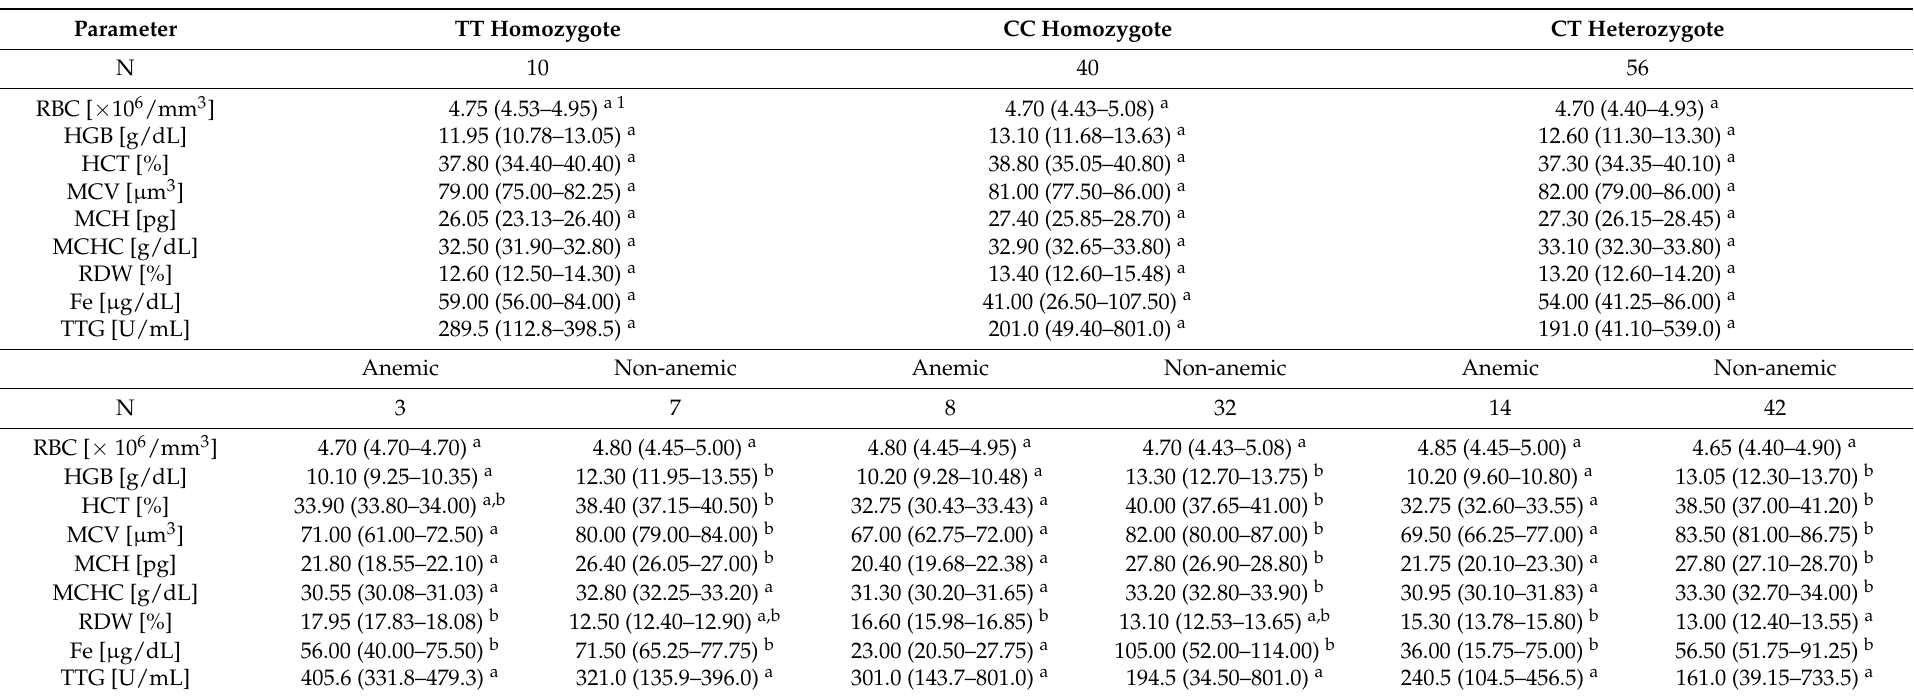
1 Comparison between the groups using Kruskal–Wallis analysis of variance. Values with the same letter in each row do not differ significantly ( p < 0.05). RBC—red blood cells; HGB—hemoglobin; HCT— hematocrit; MCV—mean corpuscular volume; MCH—mean corpuscular hemoglobin; MCHC—mean corpuscular hemoglobin concentration; RDW—red cell distribution width; Fe—iron; TTG—auto-antibodies directed against tissue transglutaminase